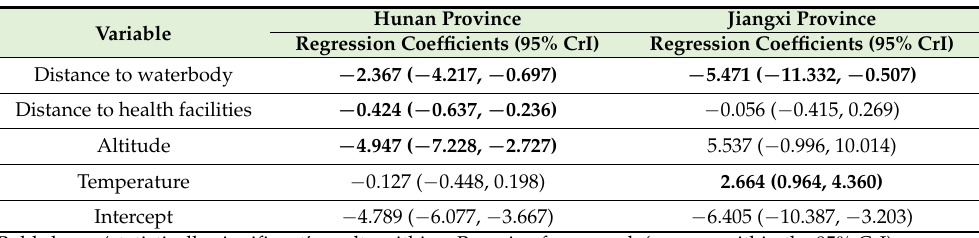
Table 3. The association of covariates and schistosome infection in Hunan and Jiangxi Provinces, derived from a logistic regression